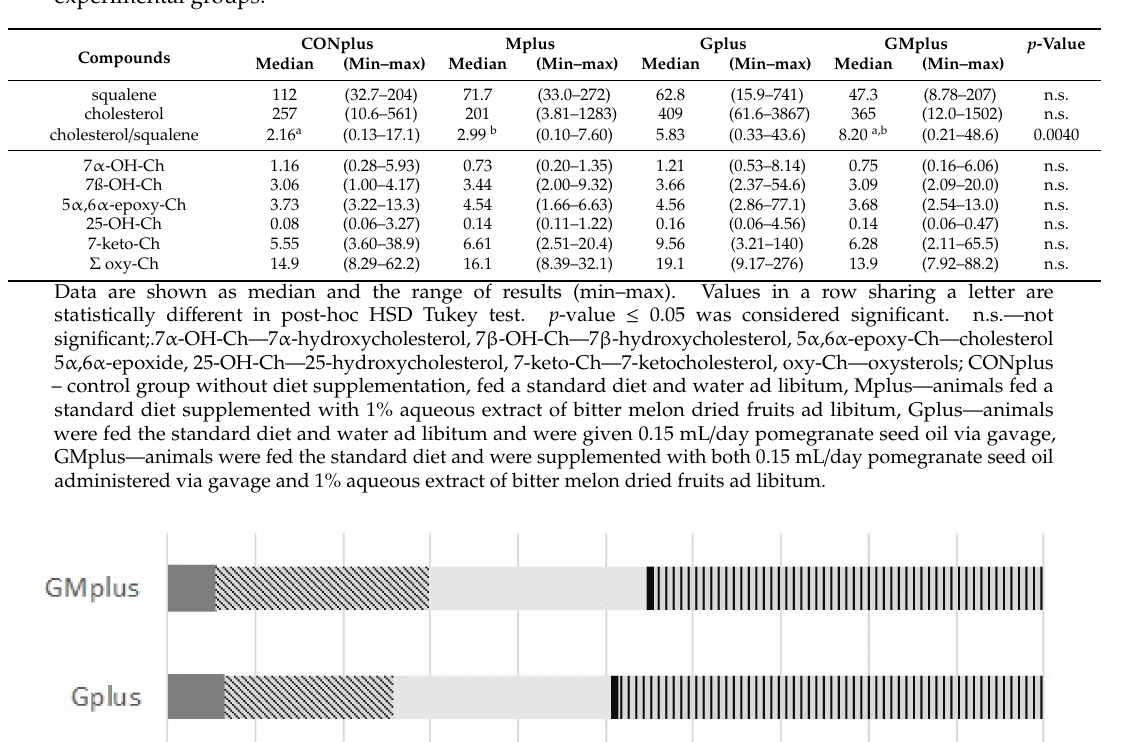
Table 7. Contents of cholesterol, squalene and oxysterols (ng / mg of tissue) in mammary tumours of experimental groups.